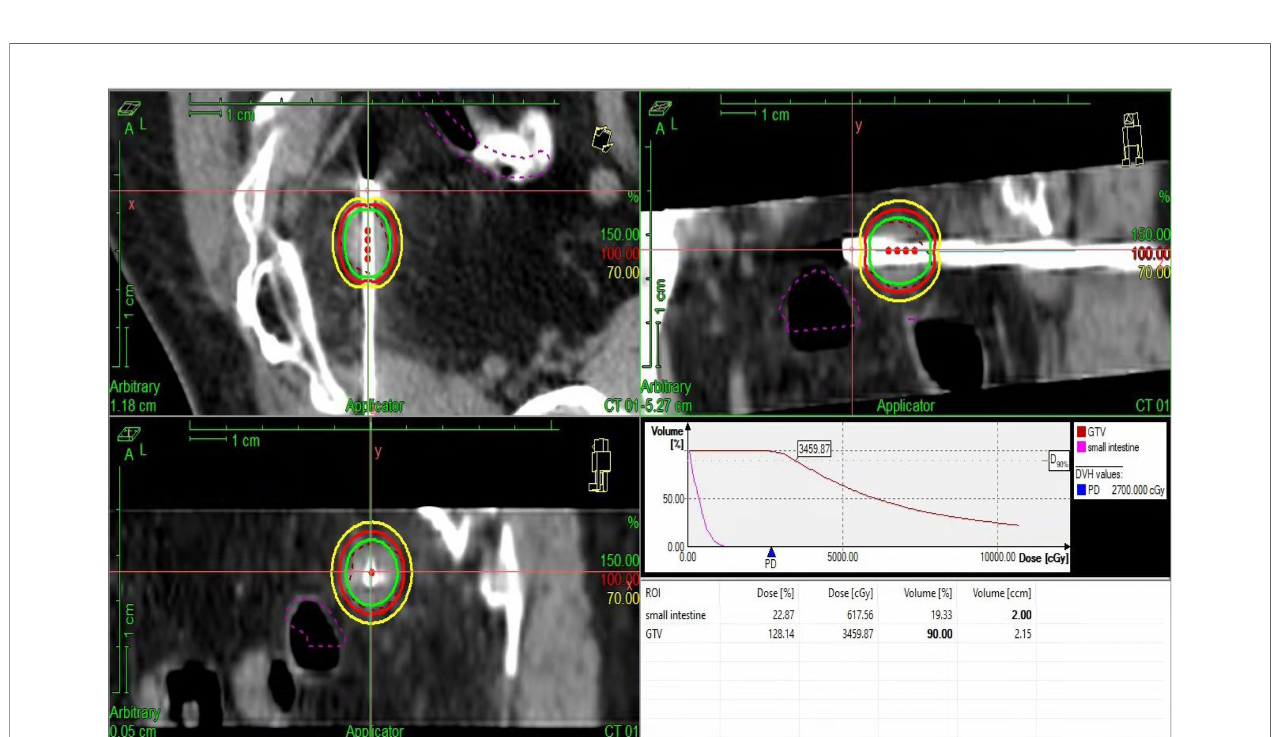
FIGURE 4 | Three-dimensional conformal dose assessment for interstitial